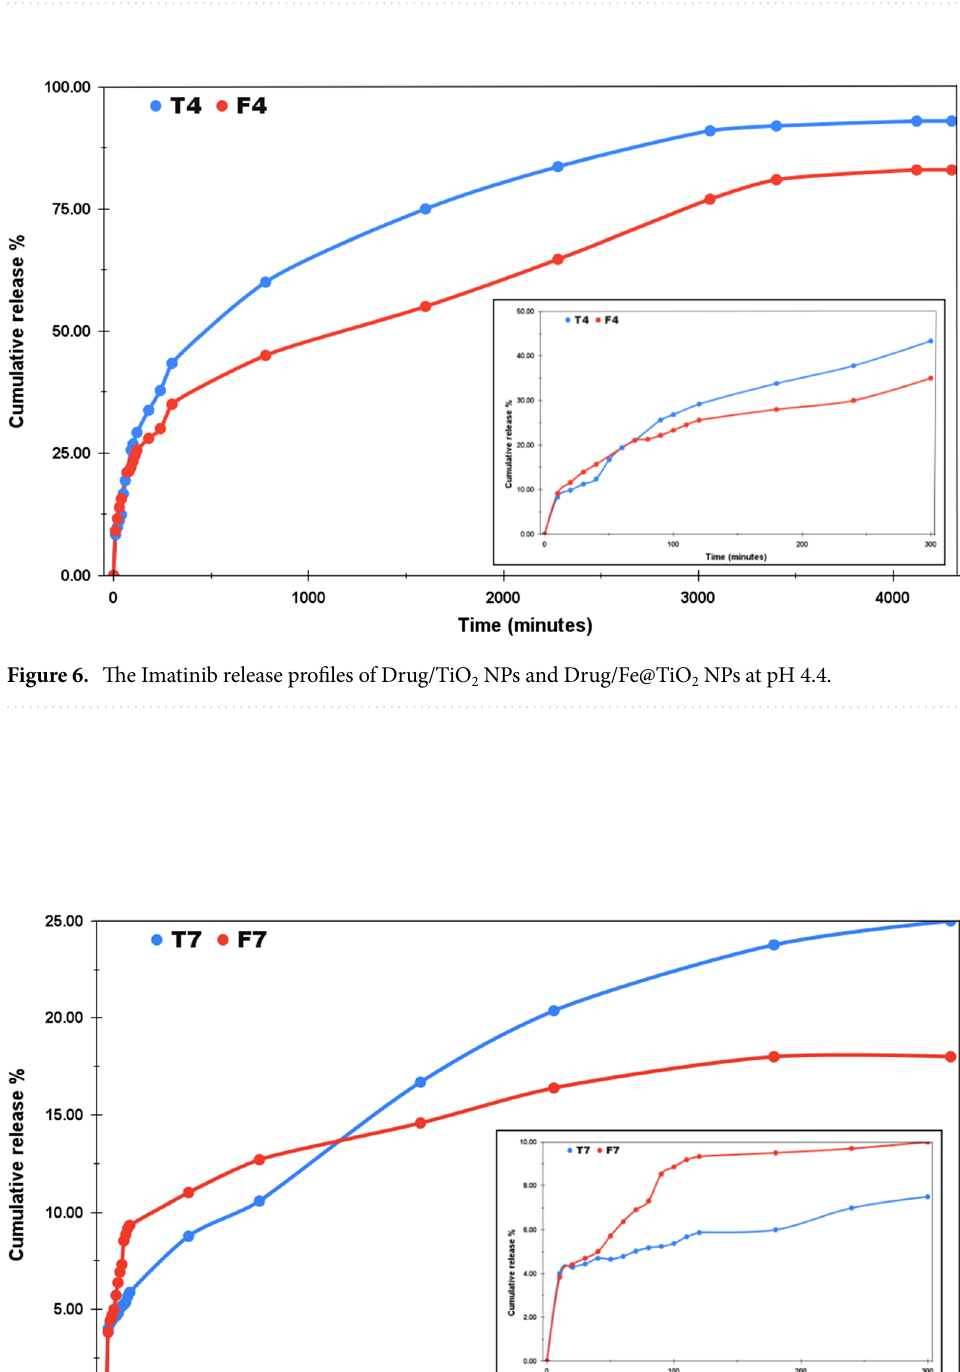
Table 3. Different terminologies used for samples under different pH levels.